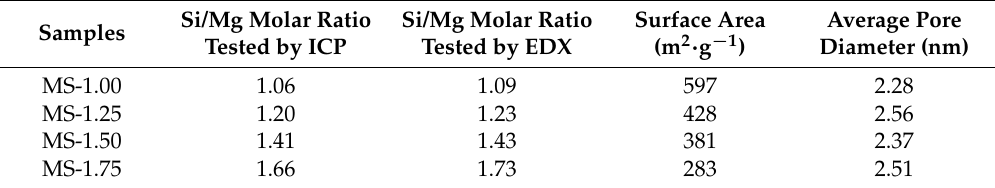
Figure 3. ( a ) N 2 isothermal profiles of four MSH samples; ( b ) the pore size distribution of four samples calculated from the density functional theory (DFT). Table 1. The inductively coupled plasma (ICP), energy-dispersive X-ray spectroscopy (EDX), and pore structure analysi results of four samples with different feeding Si/Mg ratio.